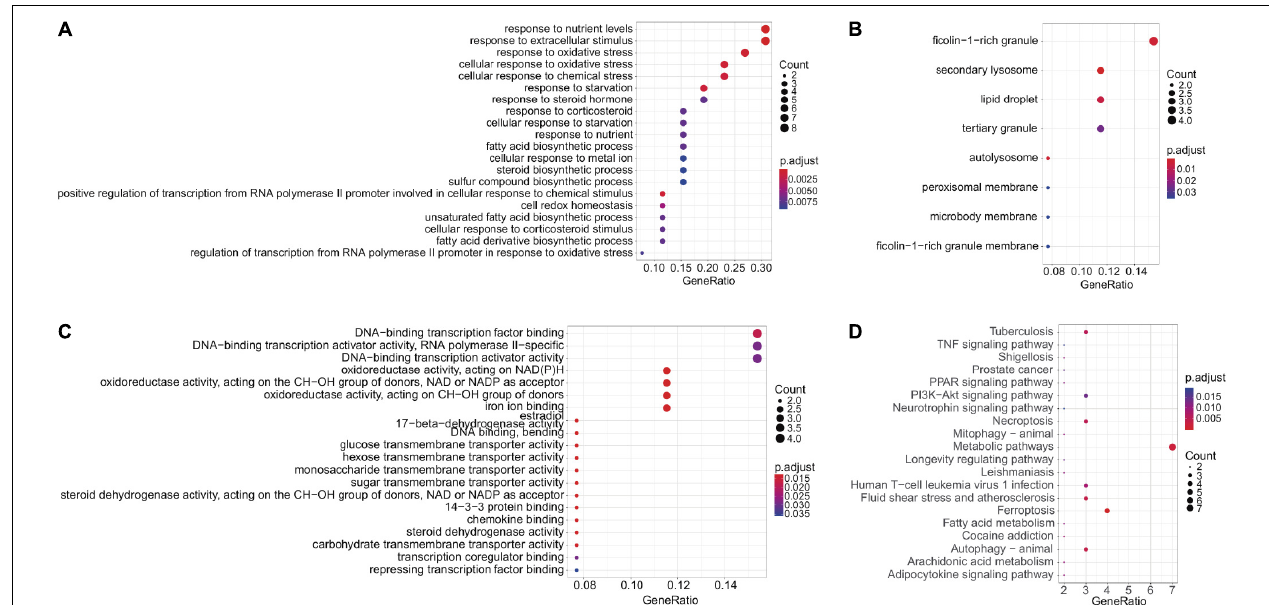
FIGURE 2 | Enrichment analysis. (A–C) GO enrichment analysis (BP, CC, and MF, respectively). (D) KEGG enrichment analysis.